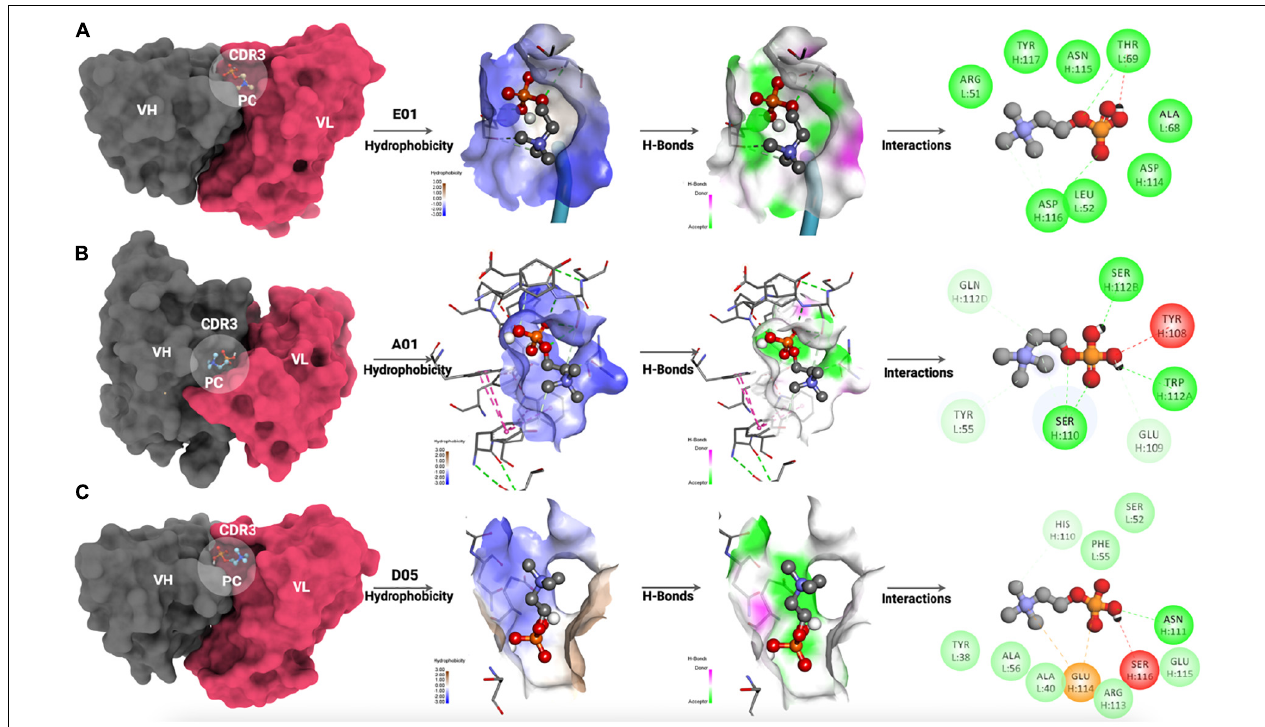
FIGURE 6 | Molecular interaction of PC with (A) E01 clone, (B) A01 clone, and (C) D05 clone antibodies. The hydrophobicity mapping, hydrogen bonding patterns, and 2D interaction map have been